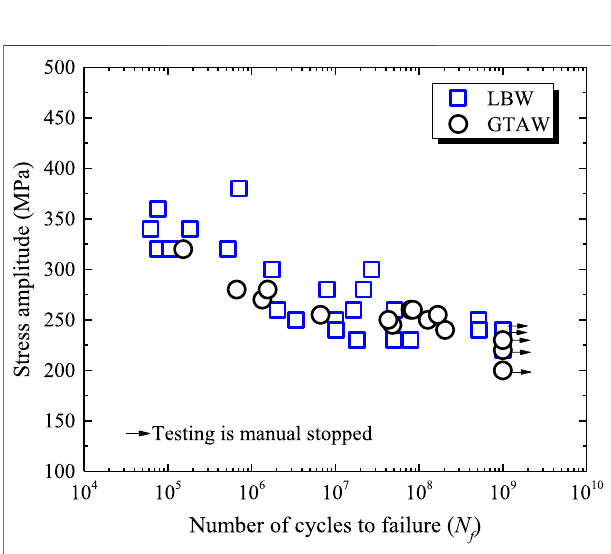
FIGURE 3 | Fatigue strength of the weldments made by BLW and